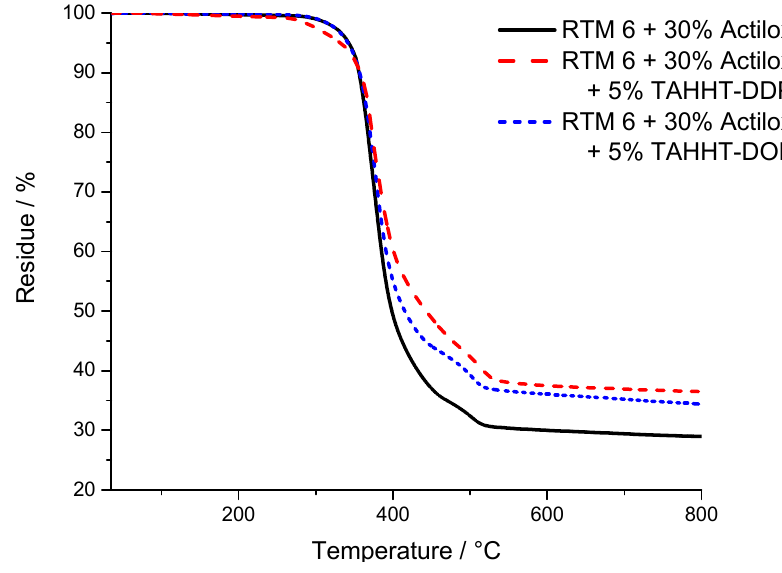
Figure 12. TG curves of Actilox-containing samples measured under N 2 -atmosphere. Polymers 2019 , 11 FOR PEER REVIEW